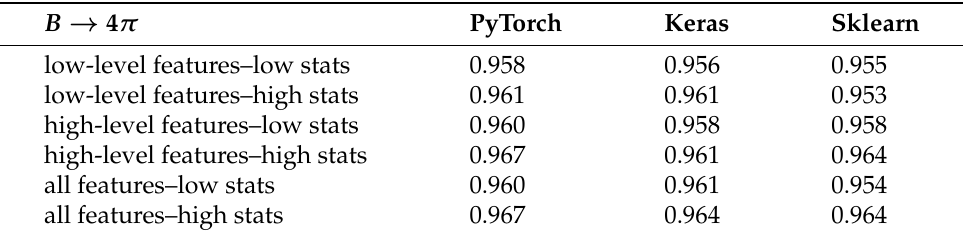
Table 8. B 4 π channel: AUC scores for the different classifiers with all the libraries. →